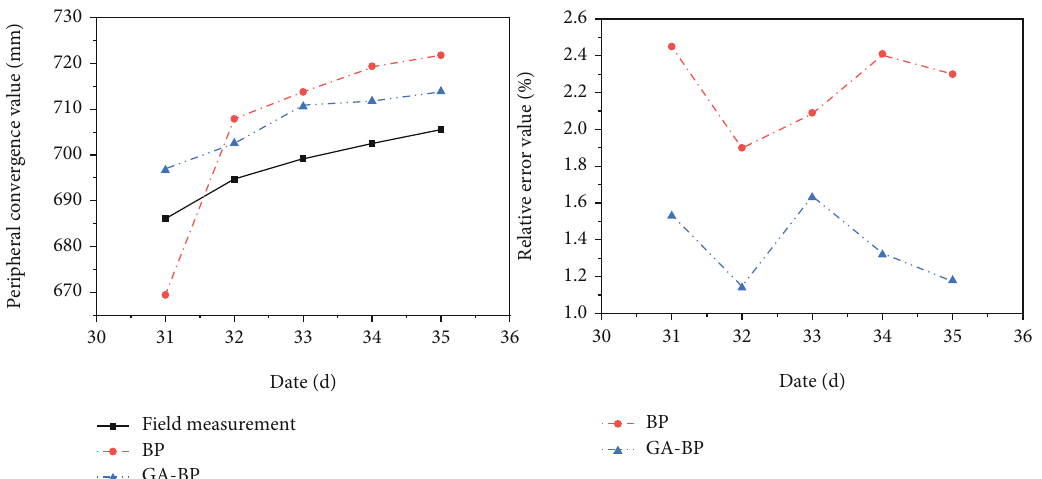
Figure 7: Early prediction results and errors.